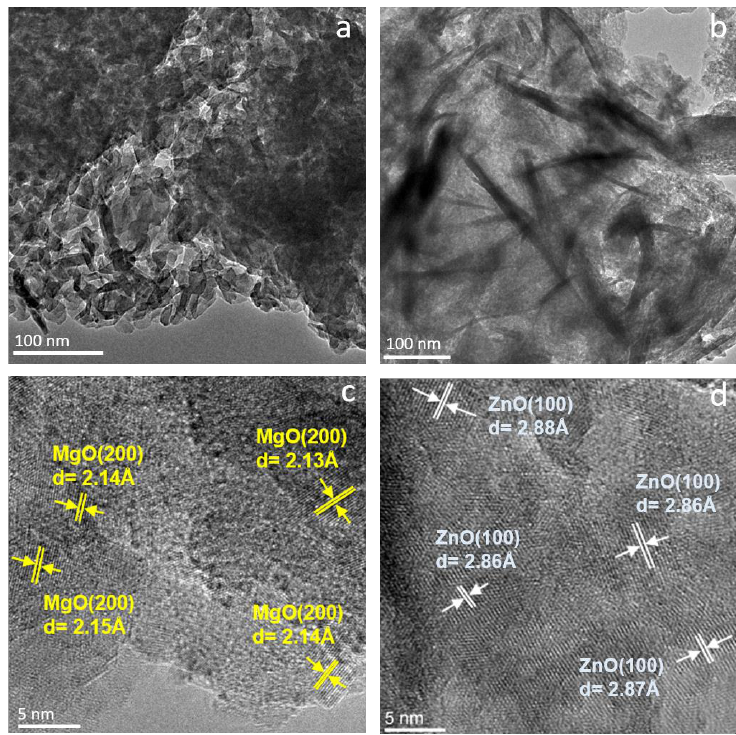
Figure 4. TEM and HRTEM images of different supported Cu catalysts: ( a , c ) Cu/MgAlO x ; ( b , d ) Cu/ZnAlO x .